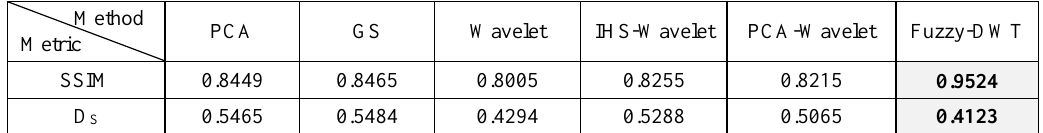
running time. Furthermore, the least value in terms of running time (0.0854 minutes) belongs to the PCA